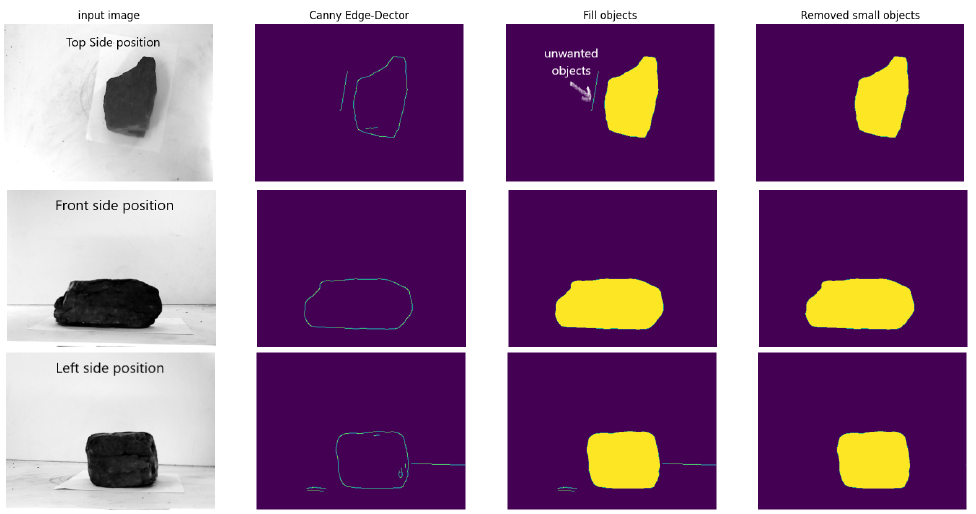
Figure 5. Image background removing steps: input images (3-side images), Edge detection, gap filling, and unwanted objects